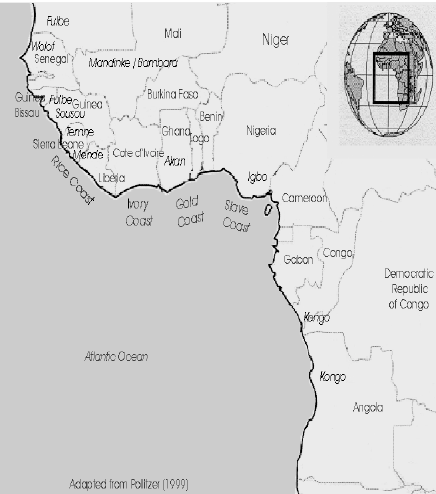
Figure 1: Map of West Coast of Africa